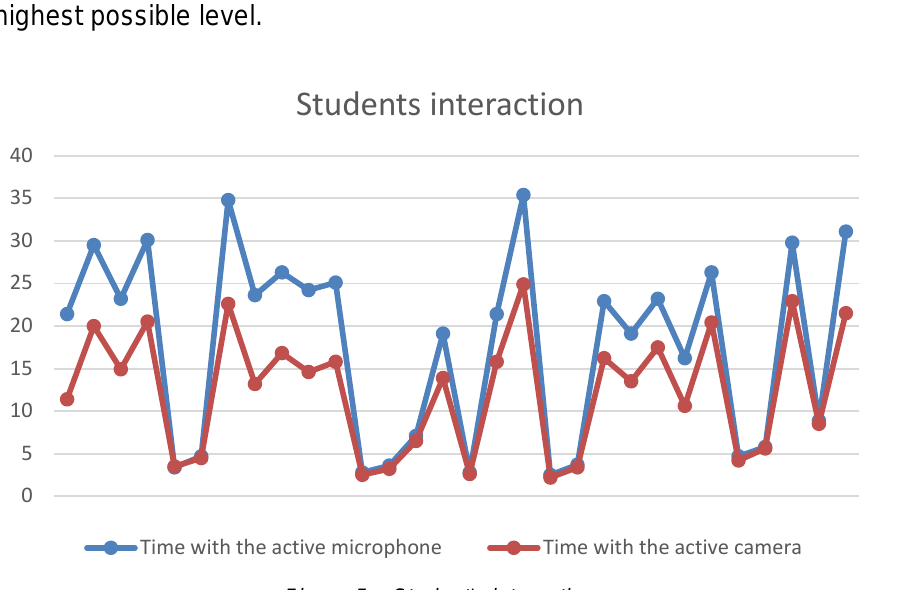
Figure 5 – Student's interaction Слика 5 – Интеракција студената Рис. 5 – Взаимодействие